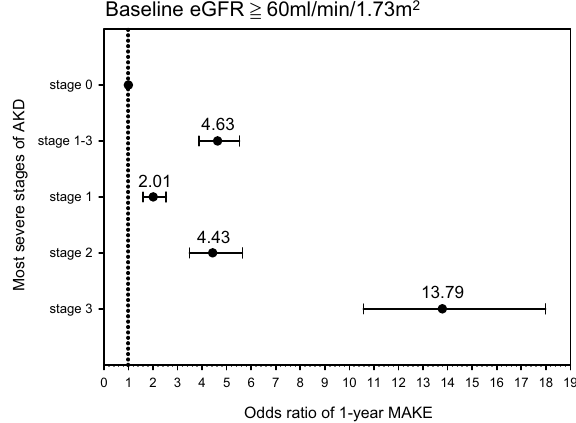
Odds ratio of 1-year MAKE Figure 4. Adjusted odds of major adverse kidney event at 1-year follow-up in higher baseline eGFR group. Odds of major adverse kidney events stratified by most severe stage of AKD between 7–90 days after AKI, according to 16th Acute Disease Quality Initiative (ADQI) recommendations, in higher baseline eGFR group. Adjusted odds ratios (dots) and 95% CIs (lines) were calculated using logistic regression, where the reference category was patients who were AKD stage 0. Logistic regression was adjusted for age, sex, hypertension, heart disease, diabetes, anemia, cerebrovascular disease, cancer, COPD and digestive tract disease. Clinical significance was observed while comparing AKD stages 1–3 versus stage 0. AKD acute kidney disease, AKI acute kidney injury, eGFR estimated glomerular filtration rate, COPD chronic obstructive pulmonary